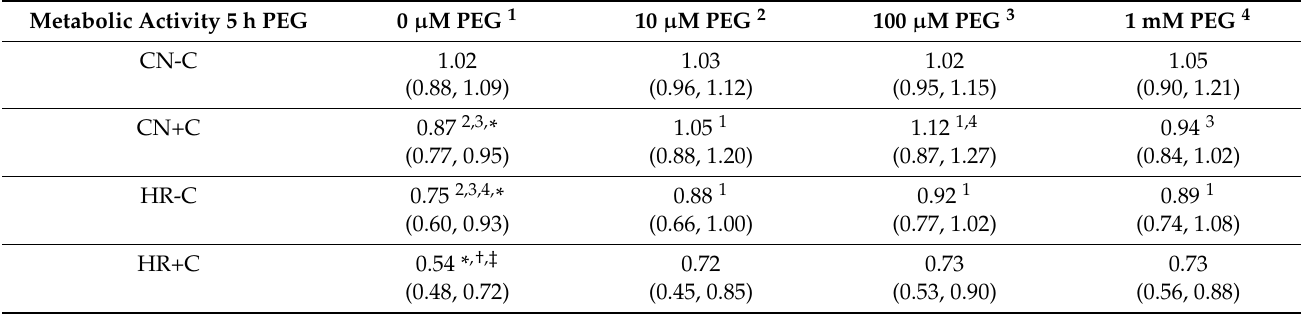
Table A10. Metabolic activity after 5 h injury and treatment with 0 µ M, 10 µ M, 100 µ M, and 1 mM of PEG. Data from Figure A6 visualized as table (median, 25th, 75th percentile); p < 0.05; n = 6–7 experiments/group. Significances between different concentrations of PEG are displayed as superscripted numbers, significances between 0 µ M PEG CN-C, CN+C, HR-C, and HR+C are represented by symbols (* vs. CN-C 0 µ M PEG, † vs. CN+C 0 µ M PEG, ‡ vs. HR-C 0 µ M PEG). Abbreviations: C, compression; CN,